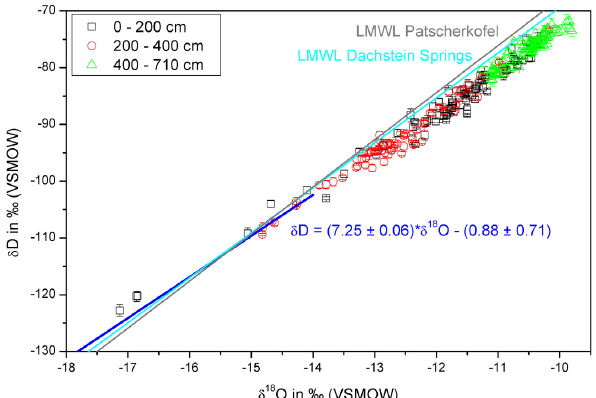
Fig. 8. δ D versus δ 18 O: the color coding denotes the three core sec- tions discussed above. The dark blue line gives the linear regression of the complete isotopic data set. The light blue and gray lines show the local meteoric water line (LMWL) derived from the data set of 12 springs in the Dachstein area (Scheidleder et al., 2001) and from the Patscherkofel site (ANIP, 2010),